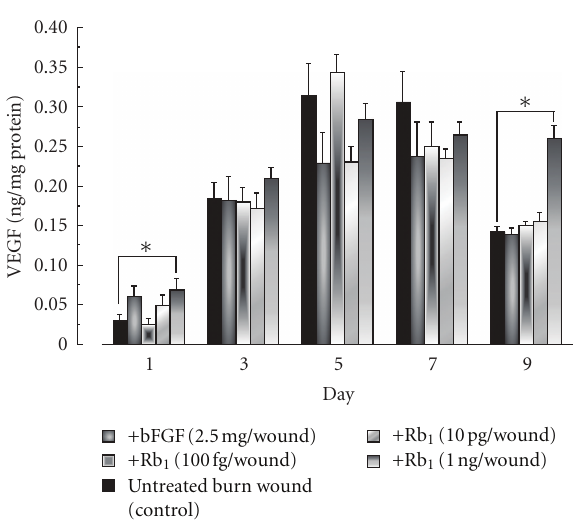
Figure 4: E ff ects of ginsenoside Rb 1 and bFGF on VEGF pro- duction in the exudates of burns in male Balb/c mice [26]. The experiments were performed as described in Figure 3, and the VEGF levels in the filter pellets were measured using a mouse IL-1 β ELISA kit. Values are the mean ± SE for 6 mice. ∗ Significantly di ff erent from control, P < 0 . 05.